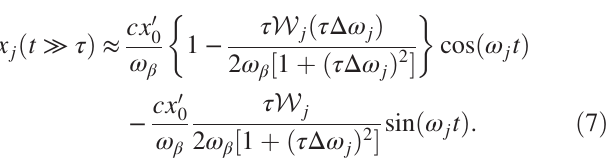
ffiffiffiffiffiffiffiffiffiffiffiffiffiffiffiffiffiffiffiffi